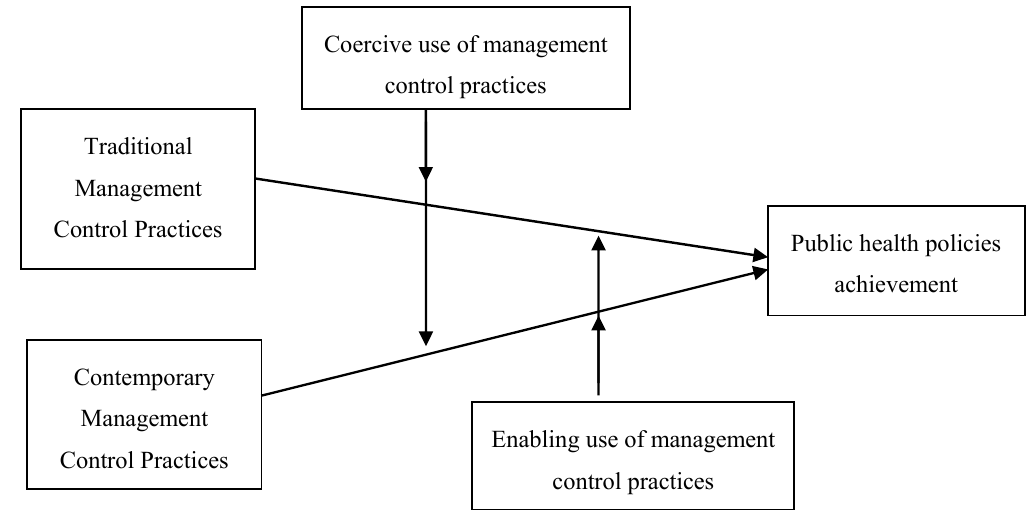
Figure 1. Overall research model.